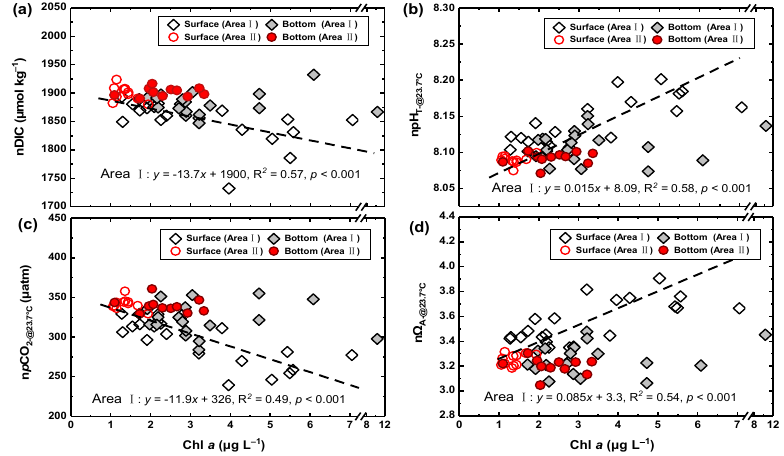
Figure A6. The nTAlk versus nDIC in the surface and bottom water of Yangmeikeng Sea Area (Area I) ( a ) and Dalu Bay (Area Ⅱ ) ( b ). Vectors illustrate the directions of the effects of photosynthesis, respiration and calcification on TAlk and DIC. The data of Area I ( n = 42) and Area Ⅱ ( n = 22) were normalized to salinity of 32.44 and 32.57, respectively.